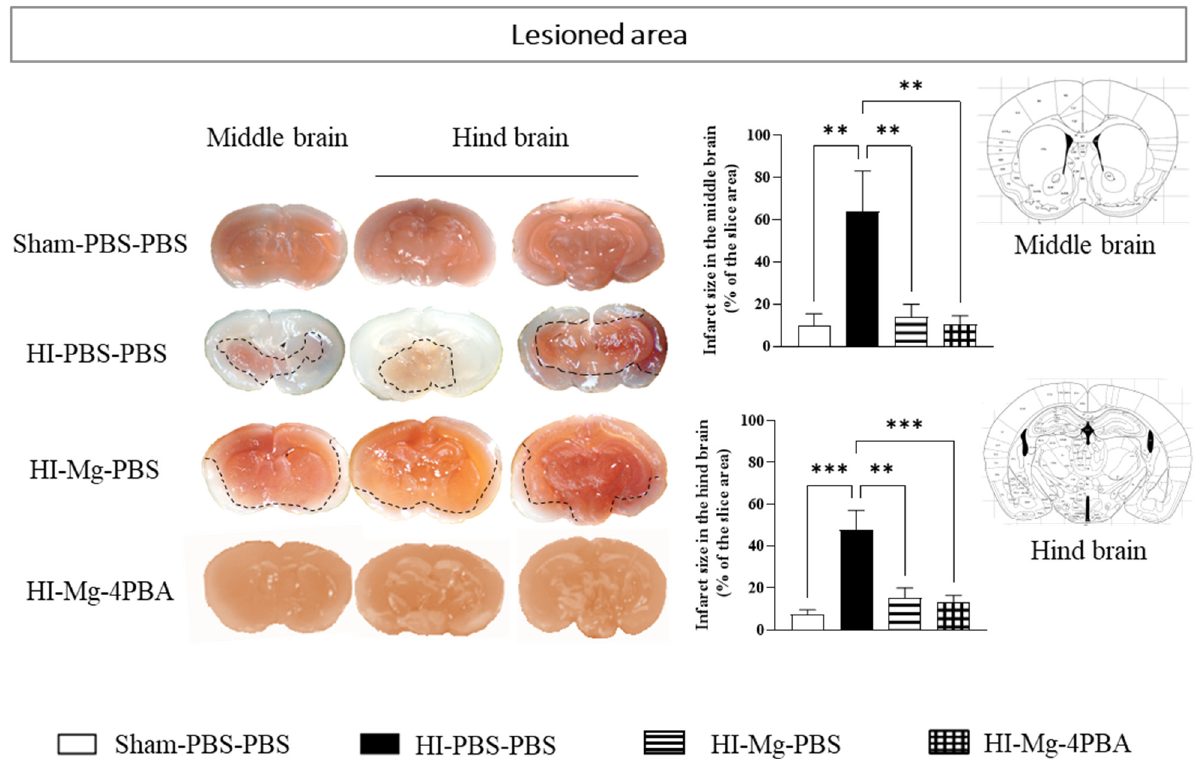
Figure 5. Effects of the neonatal HI with MgSO 4 or MgSO 4 /4-PBA association on pups’ brain tissular viability at P10. Illustration of TTC staining of brain slices at the levels of the middle brain and the hind brain of P10 pups. Quantification of the lesioned area in HI pups treated with MgSO 4 alone or with the MgSO 4 /4-PBA association. Sexes are pooled. Data are expressed as M ± S.E.M, n = 5–10 pups/group. One-way ANOVA was performed followed by Tukey’s post-test. (** p < 0.01, *** p < 0.001).